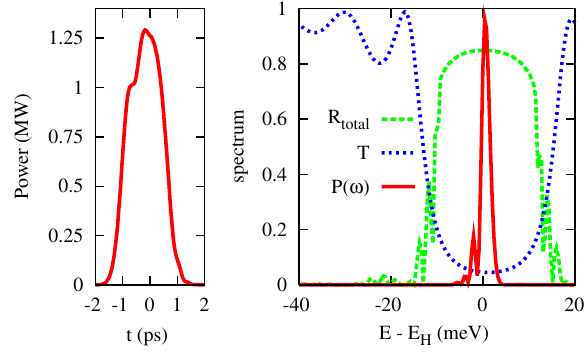
FIG. 8. Outcoupled pulse power profiles in time and energy after 1000 oscillator passes; compare with the cavity pulses plotted in the last panel of Fig. 7.